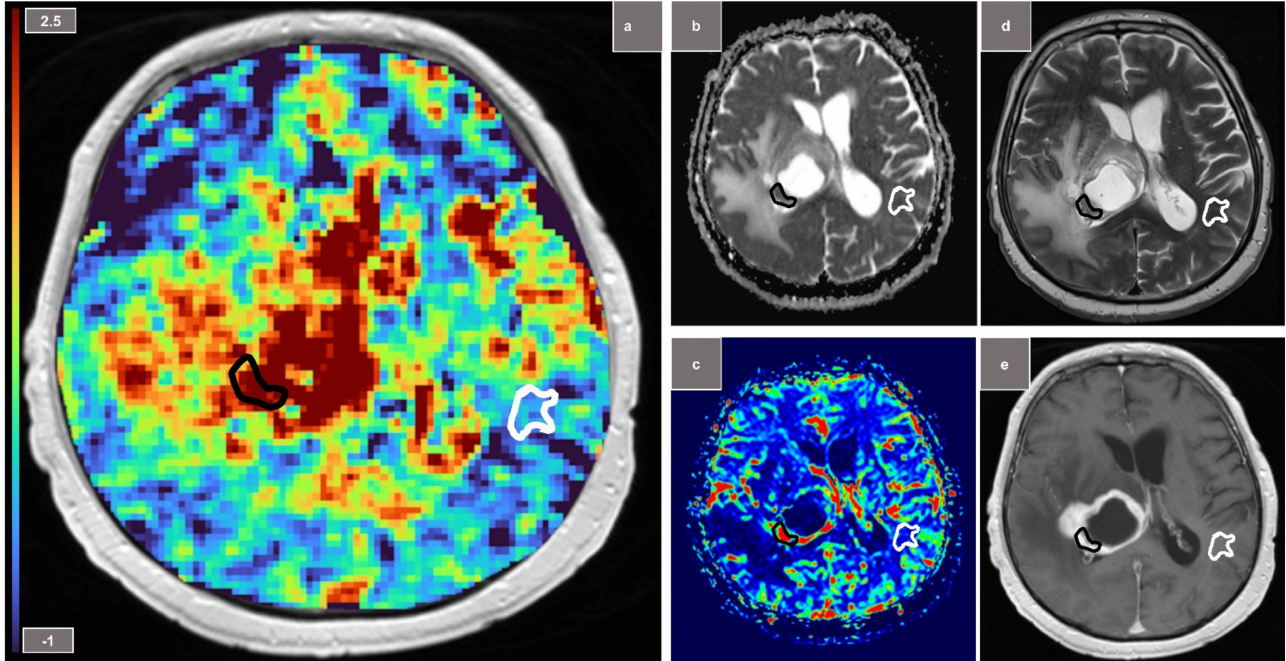
Figure 2. Glioblastoma with tumor ROI (region of interest) marked in black and NAWM (normal- appearing white matter) ROI outlined in white. ( a ) Amide proton transfer-weighted chemical exchange saturation transfer (APTw CEST) map ( b ) ADC (apparent diffusion coefficient) map ( c ) rel- ative cerebral blood volume (rCBV) map ( d ) T2-weighted TSE ( e ) gadolinium contrast-enhanced T1-weighted